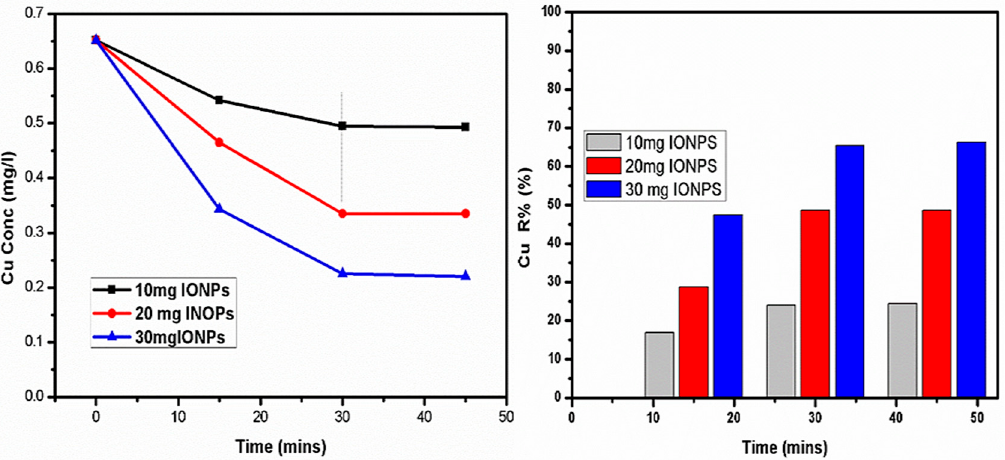
Figure 8. Removal of Cu using IONPs at different concentrations and their removal%.